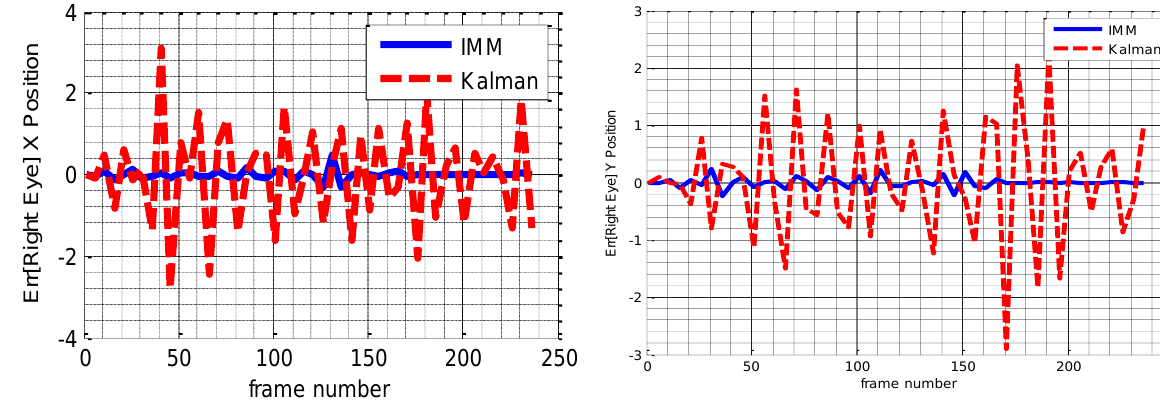
Figure 8. The error of right eye estimation of position